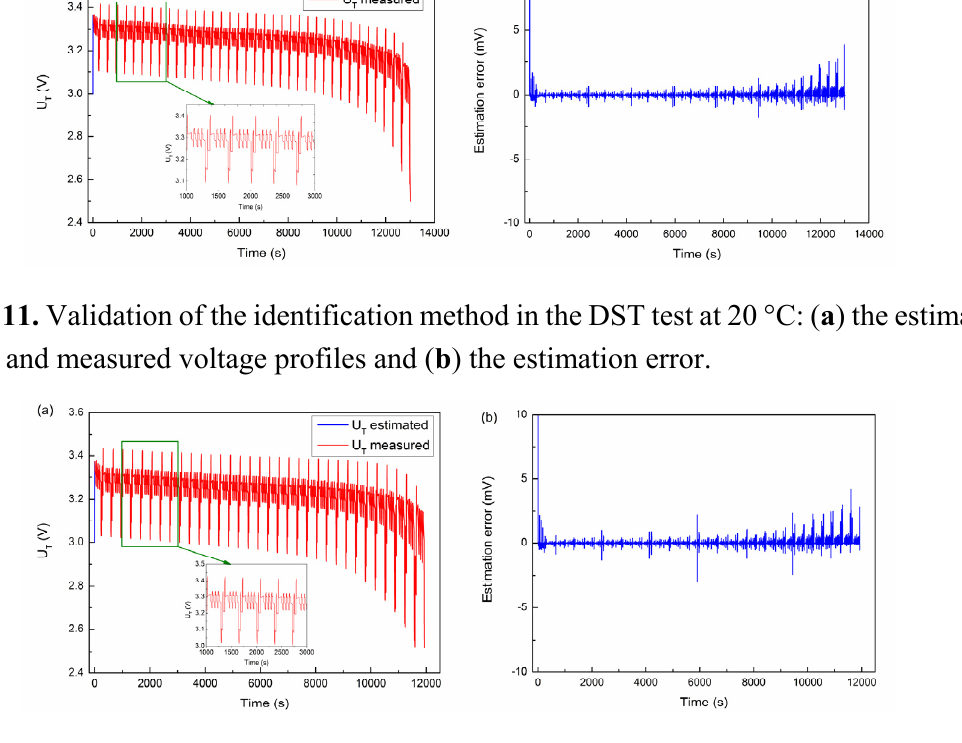
Figure 12. Validation of the identification method in the DST test at 10 °C: ( a ) the estimated voltage and measured voltage profiles and ( b ) the estimation error.